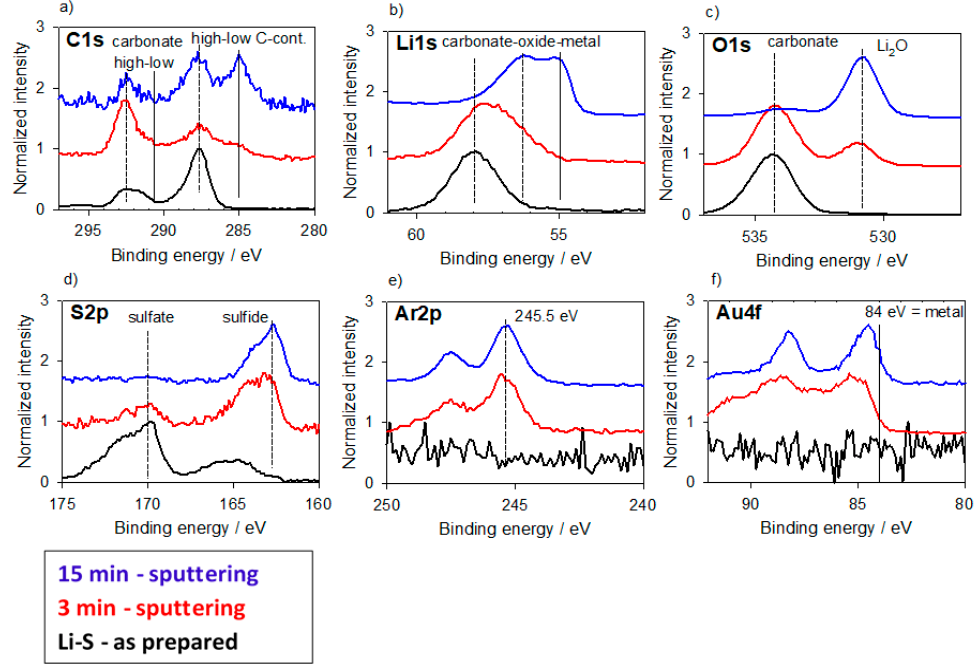
Figure 2. XP spectra normalized in intensity of a Li foil used as anode in a Li-sulfur cell: after electrochemical cycling, shortly sputtered (with Au reference) and long-time (50 nm) sputter cleaned ( bottom to top ). No charging; no charge compensation. All the characteristic peaks of the surface compounds (carbonate, fluoride, sulfate, a.o.) are shifted 2–3 eV towards higher BE; Ar2p is also at high BE of 245.5 eV. Au4f is from the beginning mainly in its metal position lower 85 eV. After long-time sputtering the surface is dominated by Li-metal and Li-oxide, however, also with the high oxide BE position always observed on top of Li-metal. ( a ) C1s; ( b ) Li1s; ( c ) O1s; ( d ) S2p; ( e ) Ar2p; ( f ) Au4f transition.